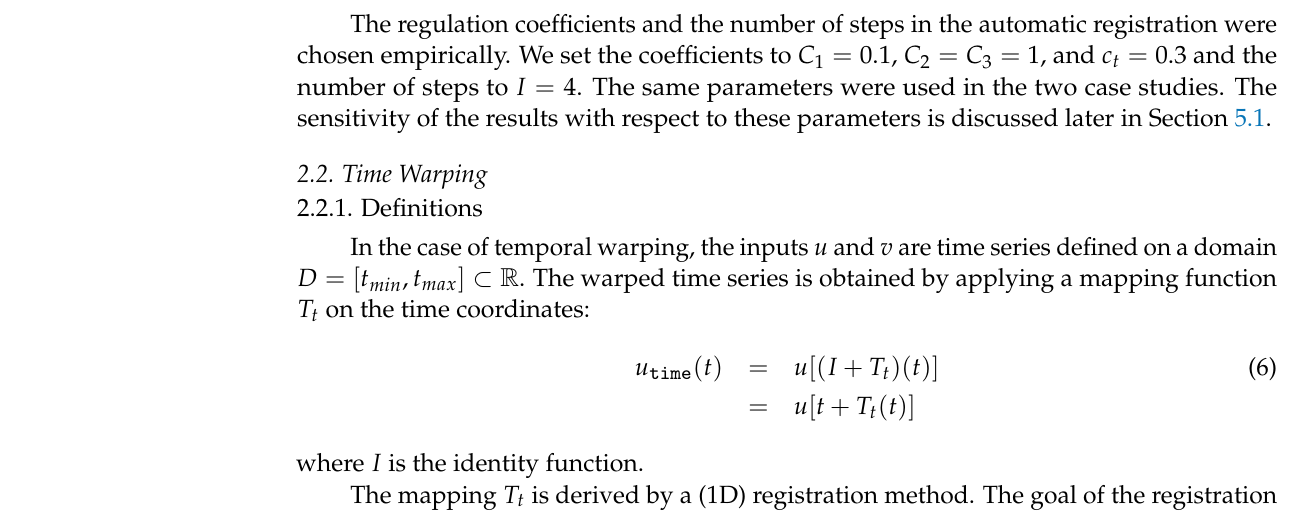
Figure 1. Flowchart of the spatial warping